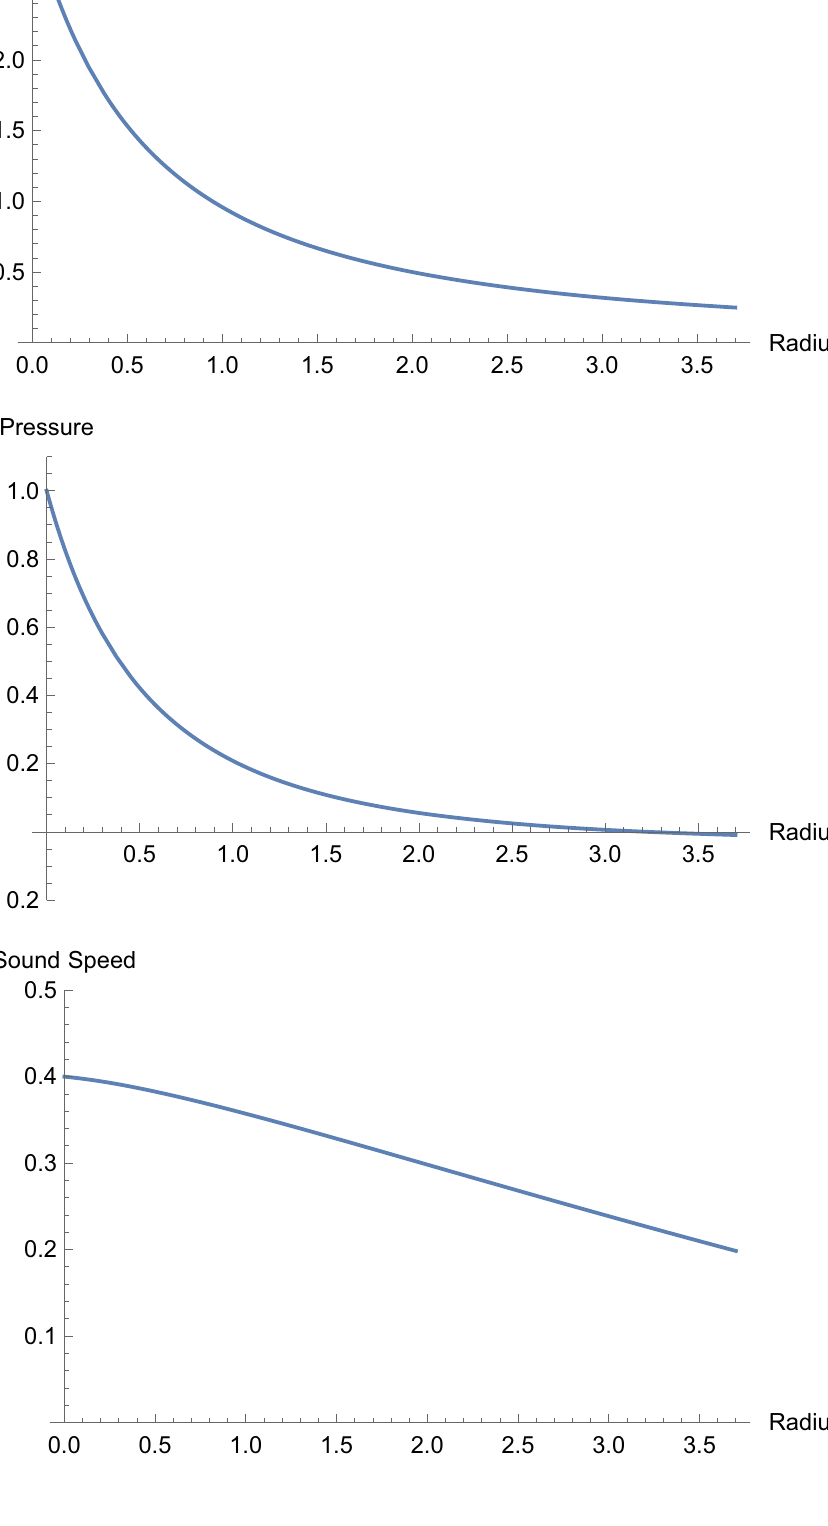
Fig. 2 Pressure p versus the radial variable x